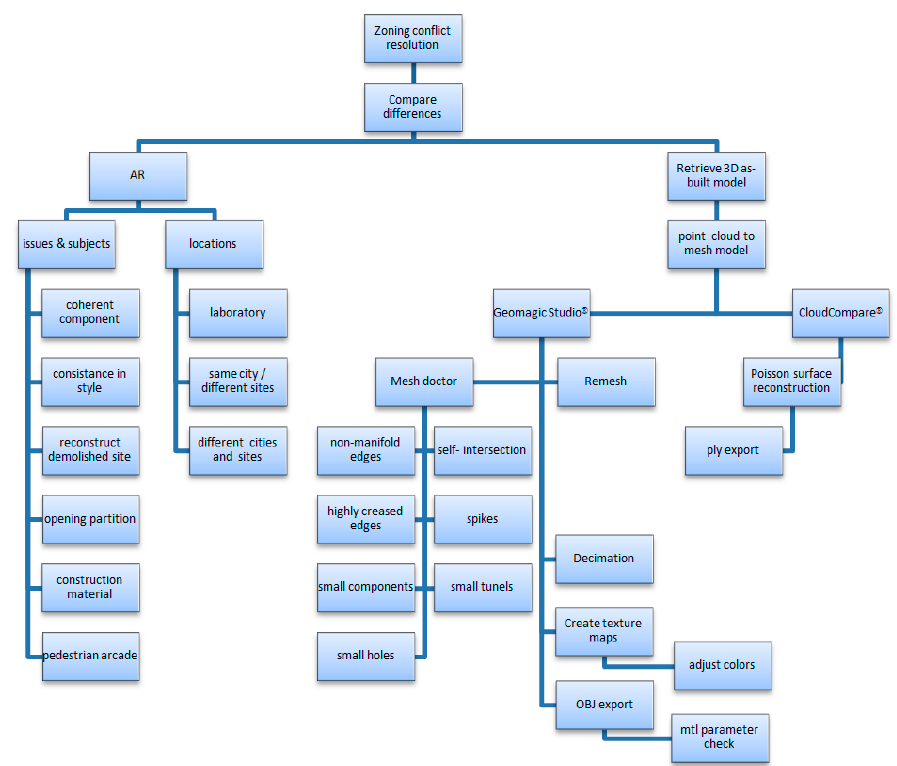
Figure 2. Flowchart of augmented reality (AR)-assisted situated comparison and the data conversion process to support the study.